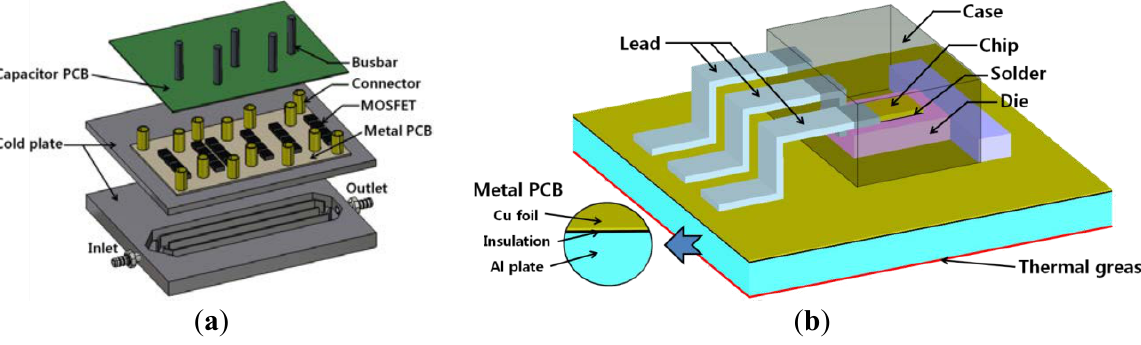
Figure 4. Analysis model of ISG inverter: ( a ) power module and cold plate; ( b ) MOSFET package and metal printed circuit board